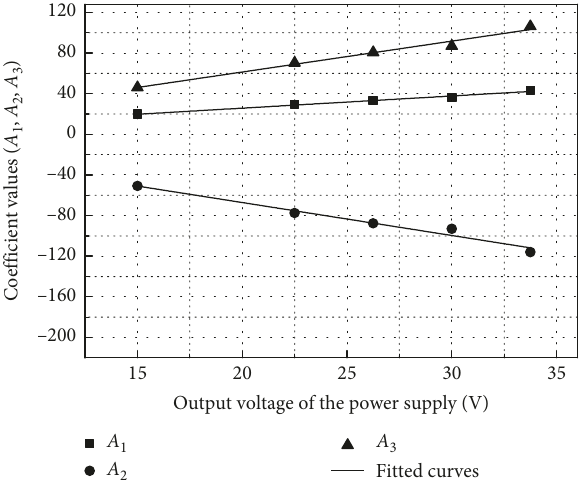
Figure 5: Fitted curves for the output voltage of the power supply and the coefficient values.